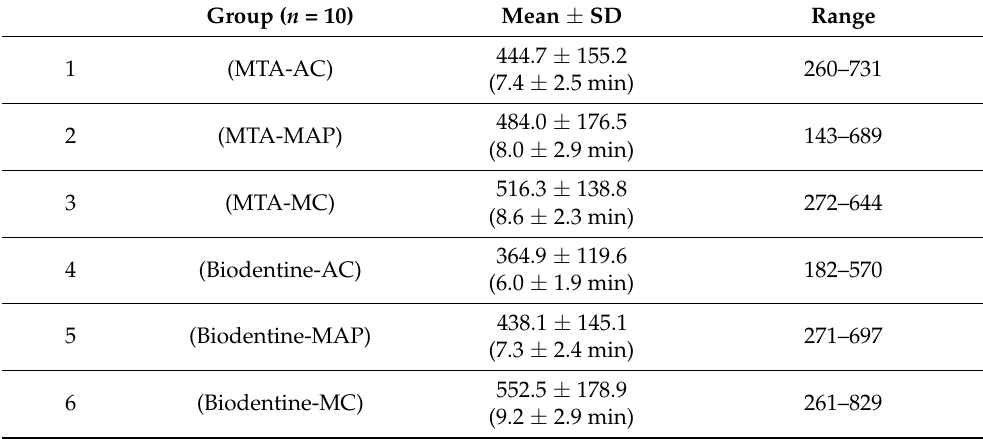
Table 2. Mean and range of apical plug formation time in seconds .